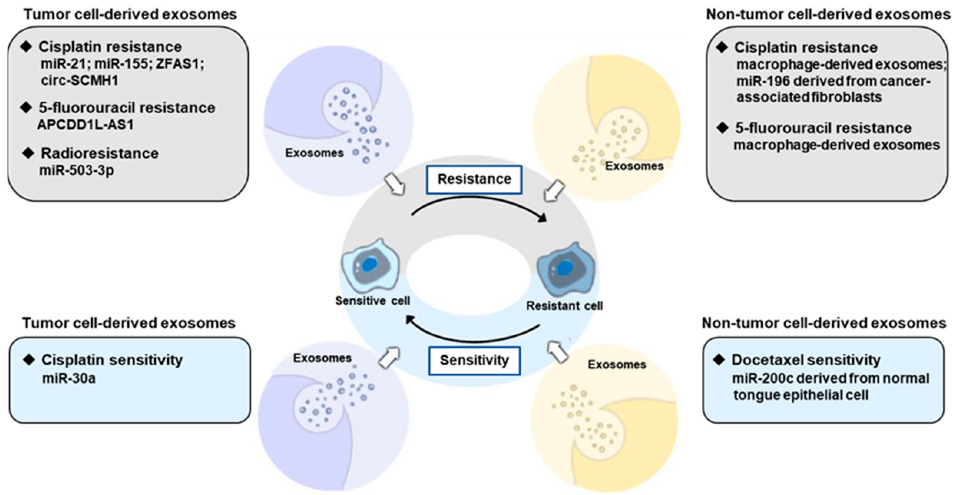
Figure 3. Exosomes in the therapeutic resistance of OSCC. Exosomes derived from both tumor cells and non-tumor cells can regulate therapy resistance of OSCC cells through multiple